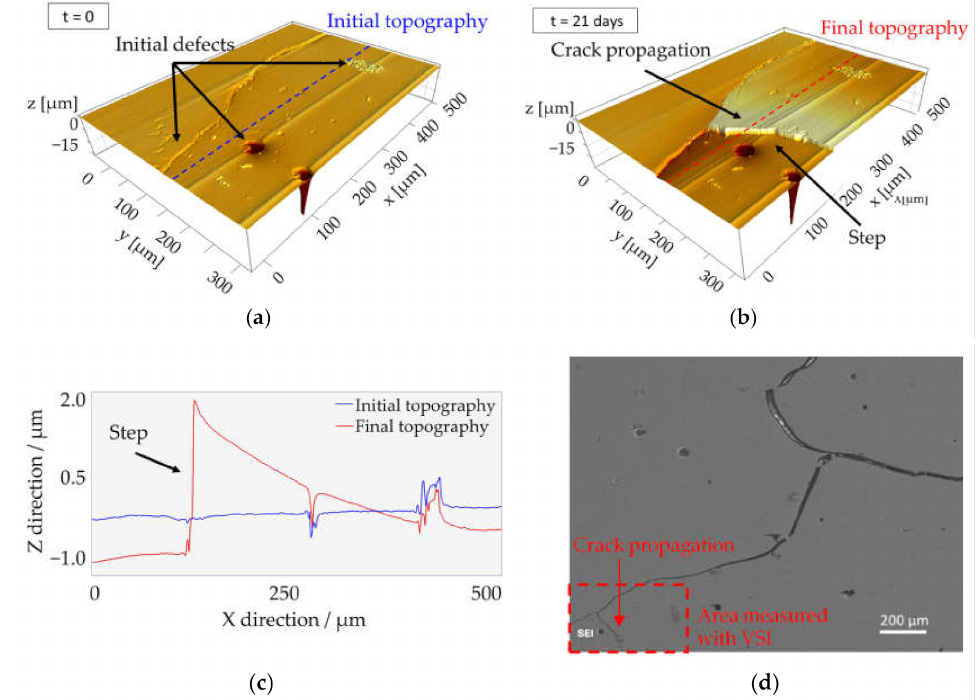
Figure 3. Topography analyses for the LPBF material: ( a ) surface area before corrosion (t = 0) obtained with VSI; ( b ) surface post-corrosion (t = 21 days) obtained with VSI; ( c ) The topography line-profiles of the initial (blue curve) and final topography (red curve). The position of the profile is identical and is shown in ( a , b ) as a dashed line; ( d ) SEM micrograph of a major crack present in the surface, indicating the area measured with the